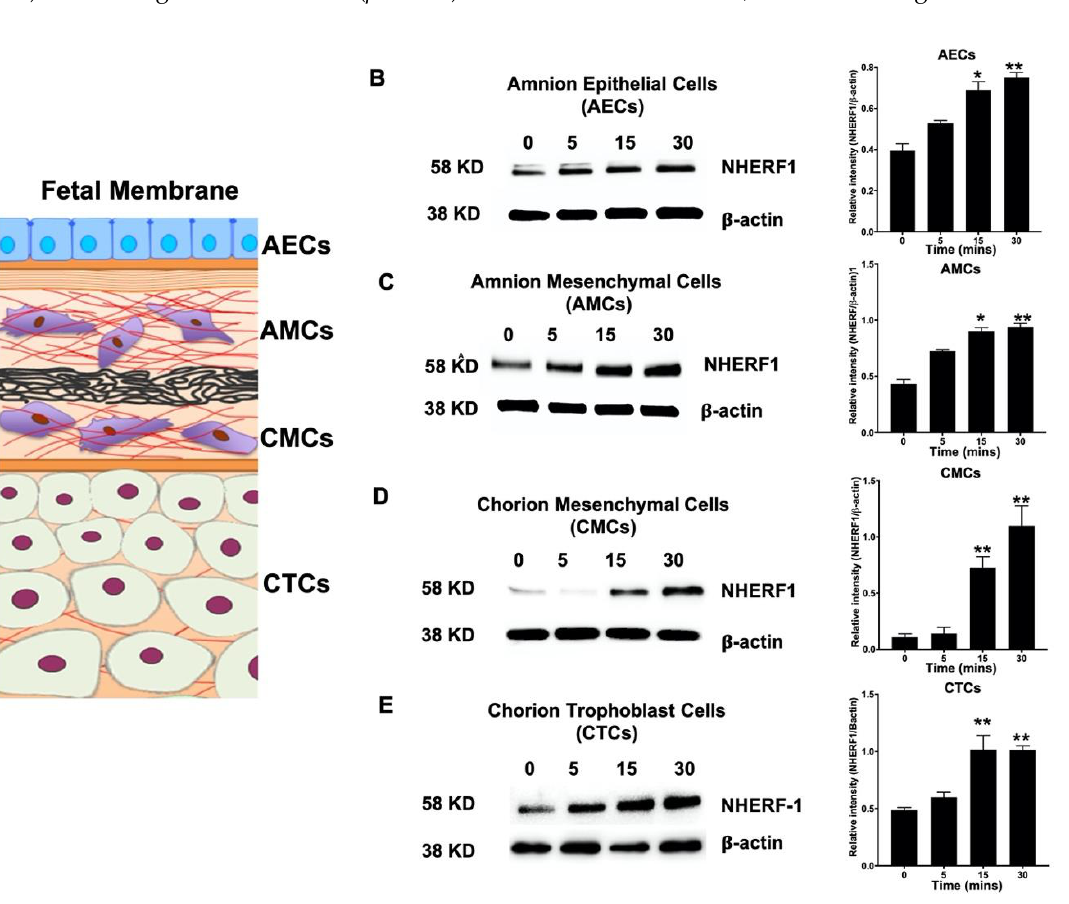
(CTCs)—following LPS stimulation ( p > 0.05) at di ff erent time intervals, as shown in Figure 4B–E.